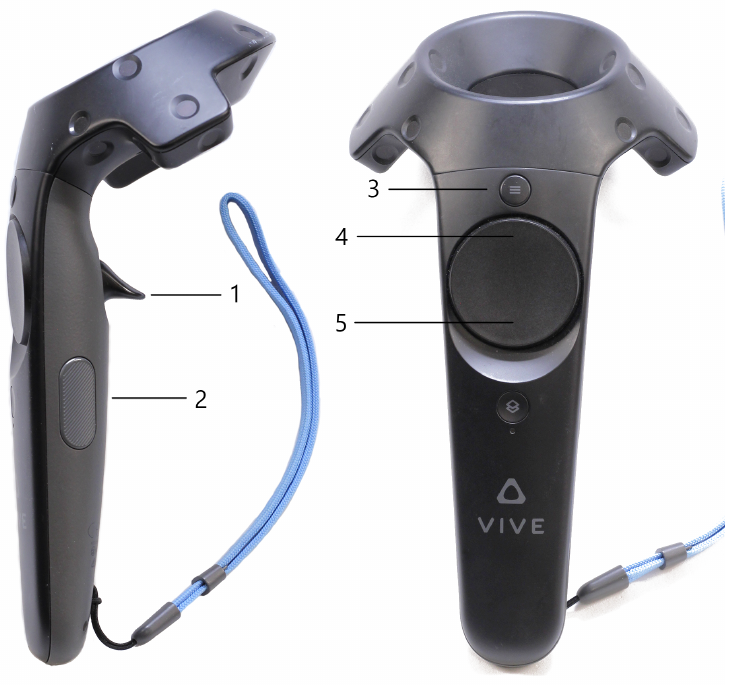
Figure 3. Overview of the Vive Wand wireless controllers. ( 1 ) Trigger—create new atoms and bonds; interact with menus. ( 2 ) Grip button—move atoms, rotate bonds, or rotate molecule. ( 3 ) Menu button—cycle controller between menu and build mode. ( 4 ) Touchpad, top quadrant—remove atom or bonds. ( 5 ) Touchpad, bottom quadrant—select atoms and bonds for measuring and